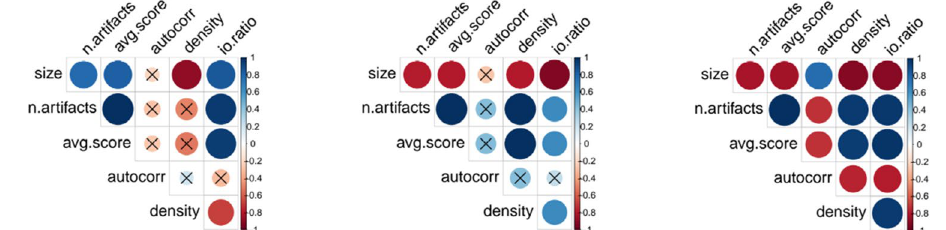
Figure 8. Correlation matrix for teams. One matrix for each group of teams is shown. Blue indicates positive correlation and red indicates negative correlation. Color intensity indicates the strength of correlation. Insignificant coefficients, according to p value p = 0.001 , are marked with a cross. Only teams whose lifespan is ten or higher are